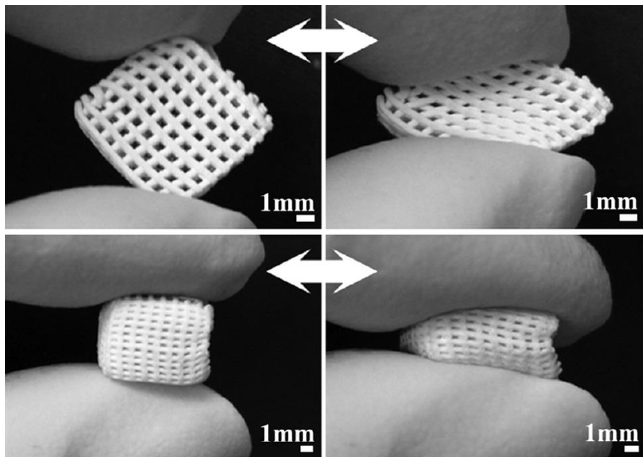
Figure 3. Compressibility of MBG/PCL composite scaffolds produced by robocasting (images adapted from Yun et al. [24] © Elsevier).